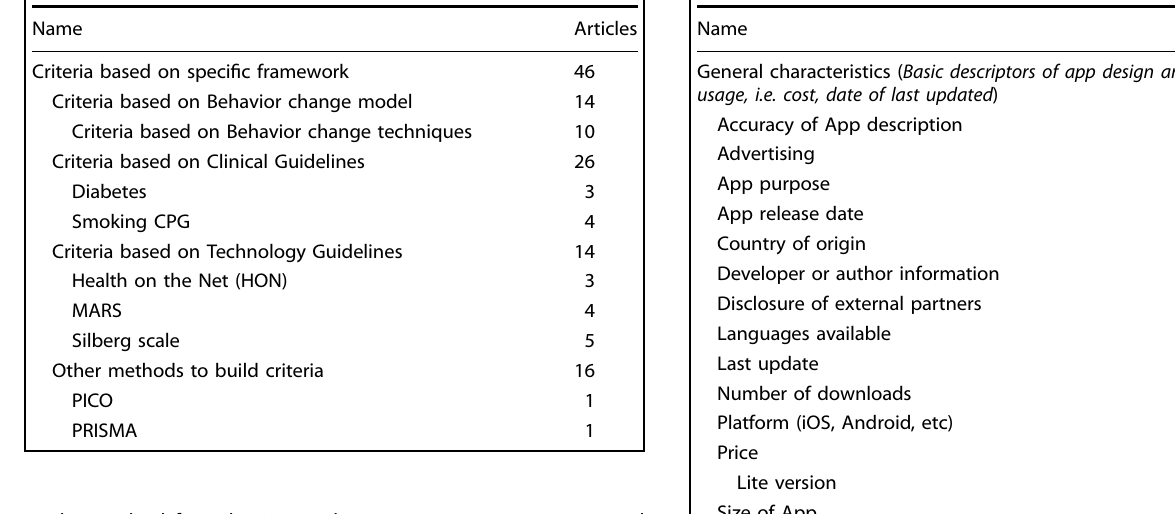
Table 2. Quality criteria synthesis. Table 1. Methods of criteria